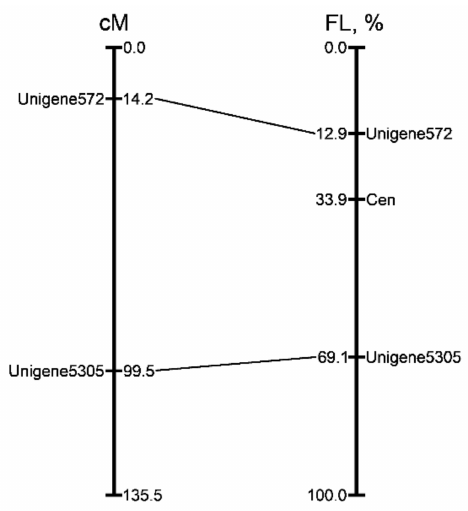
Figure 9. Alignment of the genetic and cytogenetic maps of onion chromosome 2. The position of the markers (figure on the left) in genetic map described by Fujito et al. [27]. Distances in centimorgans are shown on the right of linkage group. The physical positions (figure on the right) of two mapped markers are expressed as a percentage of the fractional length (distance from the end of the short arm to the signals divided by the length of the entire chromosome). Corresponding positions on the genetic map are indicated with